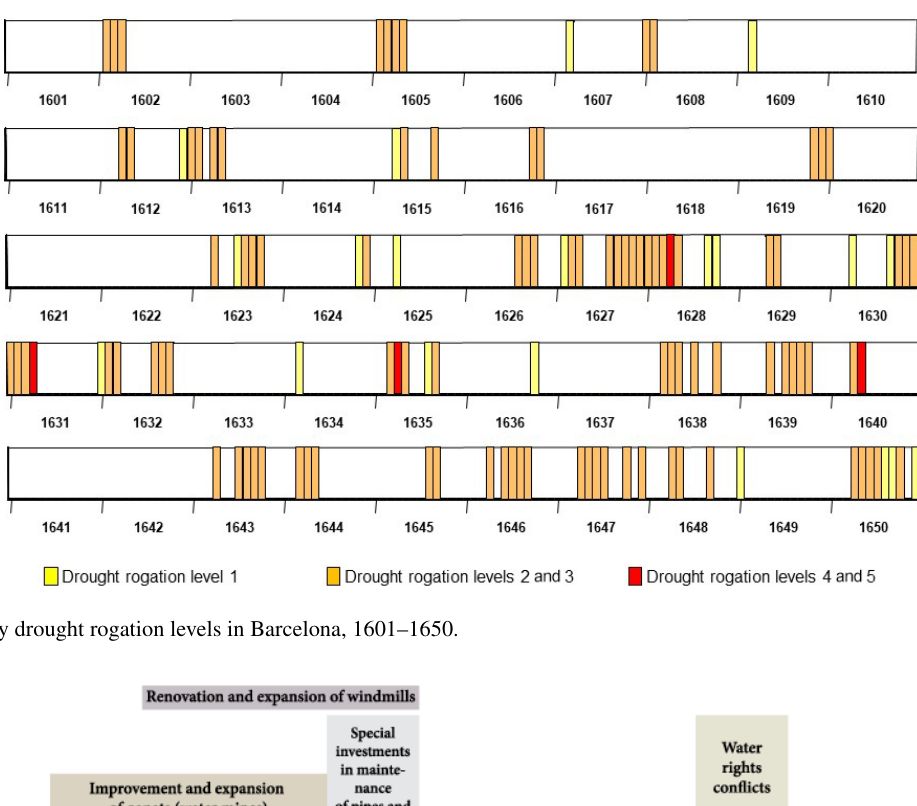
Figure 7. Strategies of institutional response to drought (1627–1636). Source: the present